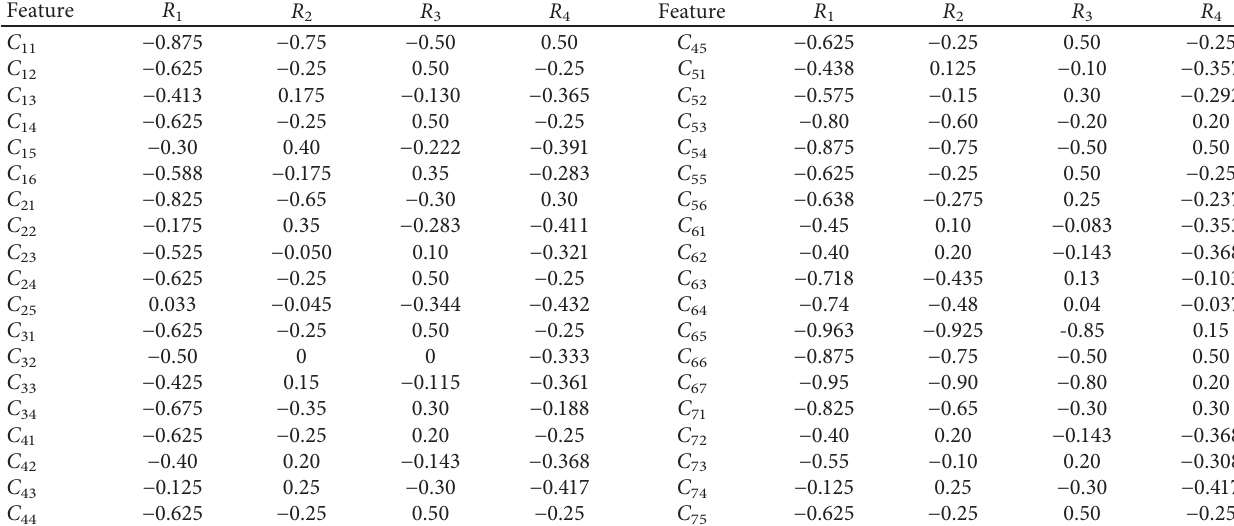
Table 6: Results on extenics correlation.